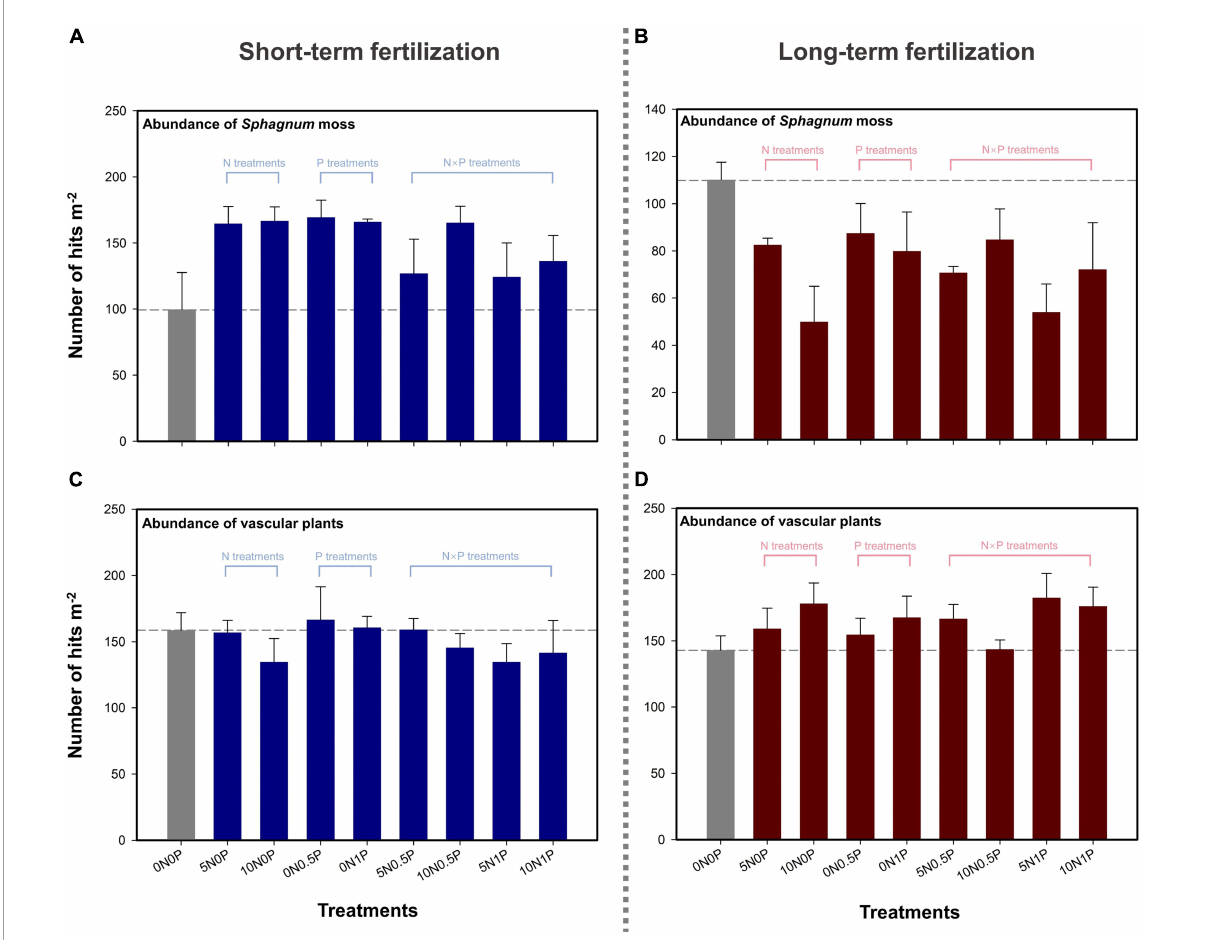
FIGURE1 Abundance of Sphagnum moss (A,C) and vascular plants (B,D) in response to the short- and long-term